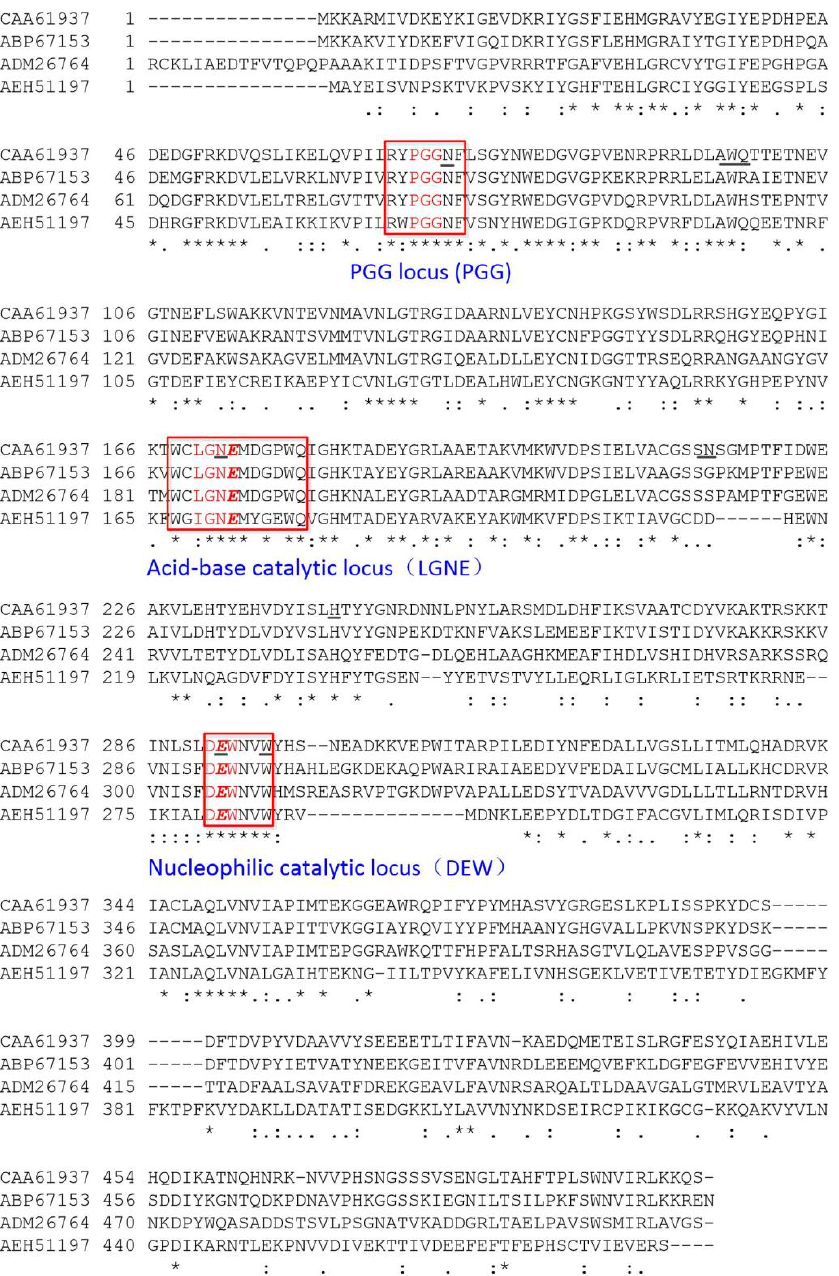
Figure 3. Multiple sequence alignment of BsAbfA with α - L -arabinofuranosidases from several microorganisms: CAA61937 (BsAbfA) from B. subtilis , ADM26764 from R. ginsenosidimutans Gsoil 3054, ABP67153 from T. thermarum DSM5069, and AEH51197 from Pseudothermotoga thermarum DSM 5069. The three motifs with conserved RYPGG (residues 67 – 73), WCLGNEMDGPWQ (resi- dues 168 – 179), and DEWNVW (residues 291 – 296) are highlighted in a box. The residues E173 and E292 (Red bold italic letters) are regarded as typical and necessary acid-base and nucleophilic cata- lytic residues for the hydrolysis of the glycosidic bond.